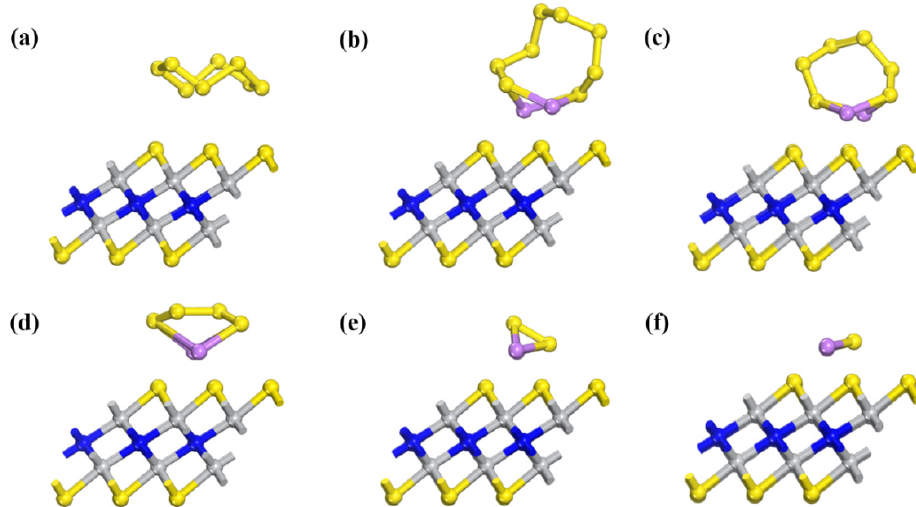
Figure 5. The optimized structures of Ti 2 NS 2 absorbing ( a ) S 8 , ( b ) Li 2 S 8 , ( c ) Li 2 S 6 , ( d ) Li 2 S 4 , ( e ) Li 2 S 2 , and ( f ) Li 2 S. Purple balls represent Li atoms. Yellow balls represent S atoms. Gray balls represent Ti atoms. Blue balls represent N atoms. Table 1. The adsorption energy (E ads ), shortest distance between Li 2 S x species and Ti 2 NS 2 , the charge transfer (Q, a positive value means that the substrate loses electrons from Li 2 S x , a negative value is the opposite) when Ti 2 NS 2 adsorbs Li 2 S x species.